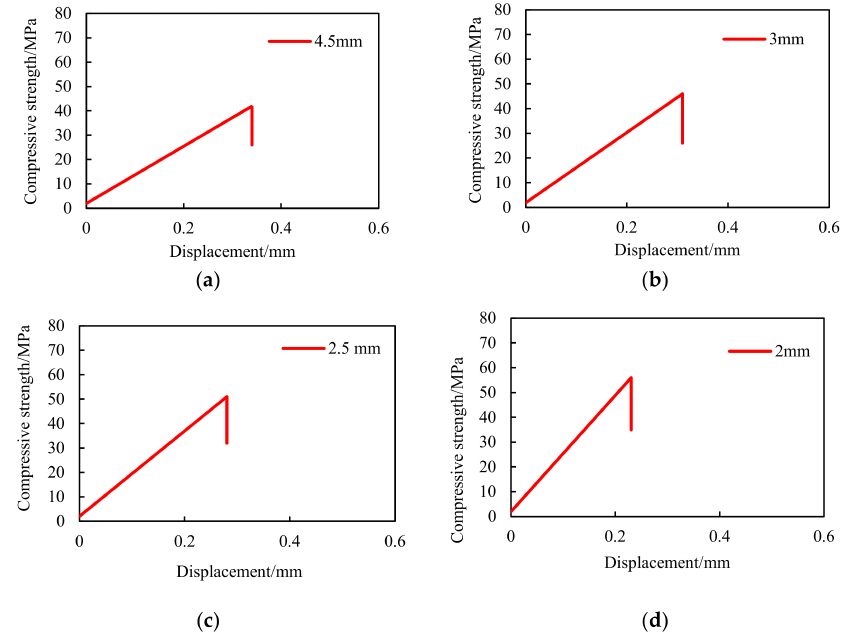
Figure 17. Compressive strength of cured proppants with different sizes. (( a – d ) are the compressive strengths of proppants with particle sizes of 4.5 mm, 3 mm, 2.5 mm and 2 mm, respectively.)